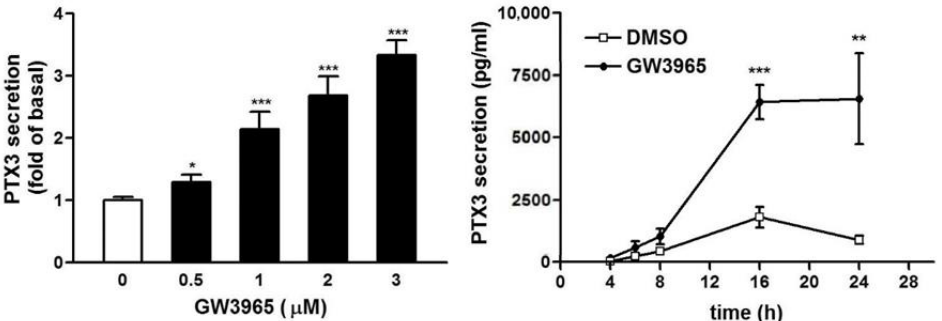
Figure 5. GW3965 induces PTX3 protein release in fibroblast culture medium. The human fibroblasts were treated with (left panel) the GW3965 for 16 h or (right panel) vehicle (DMSO) or GW3965 (3 μM). The PTX3 level in culture medium was measured by ELISA ( n = 4). * p < 0.05, ** p < 0.01 and *** p < 0.001 versus control (0 μ M of GW3965 or DMSO only).